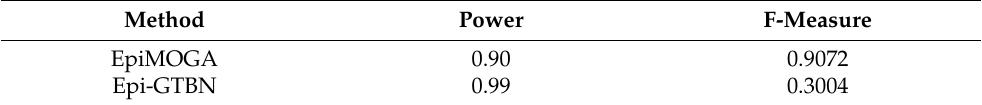
Table 1. Two index values of EpiMOGA and Epi-GTBN in the DME2 dataset (sample size = 800).